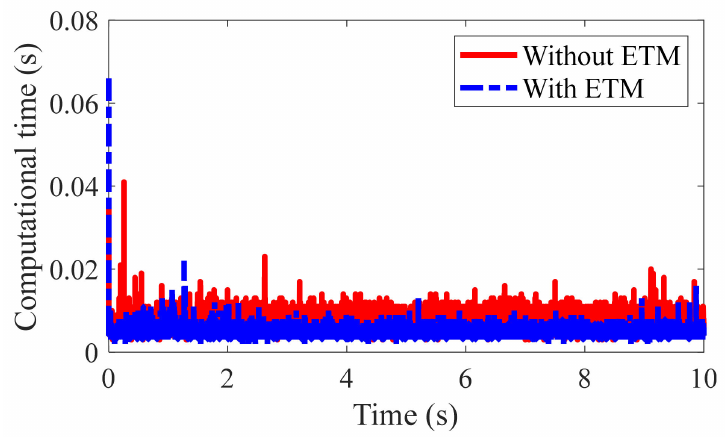
Figure 8. Computational time.